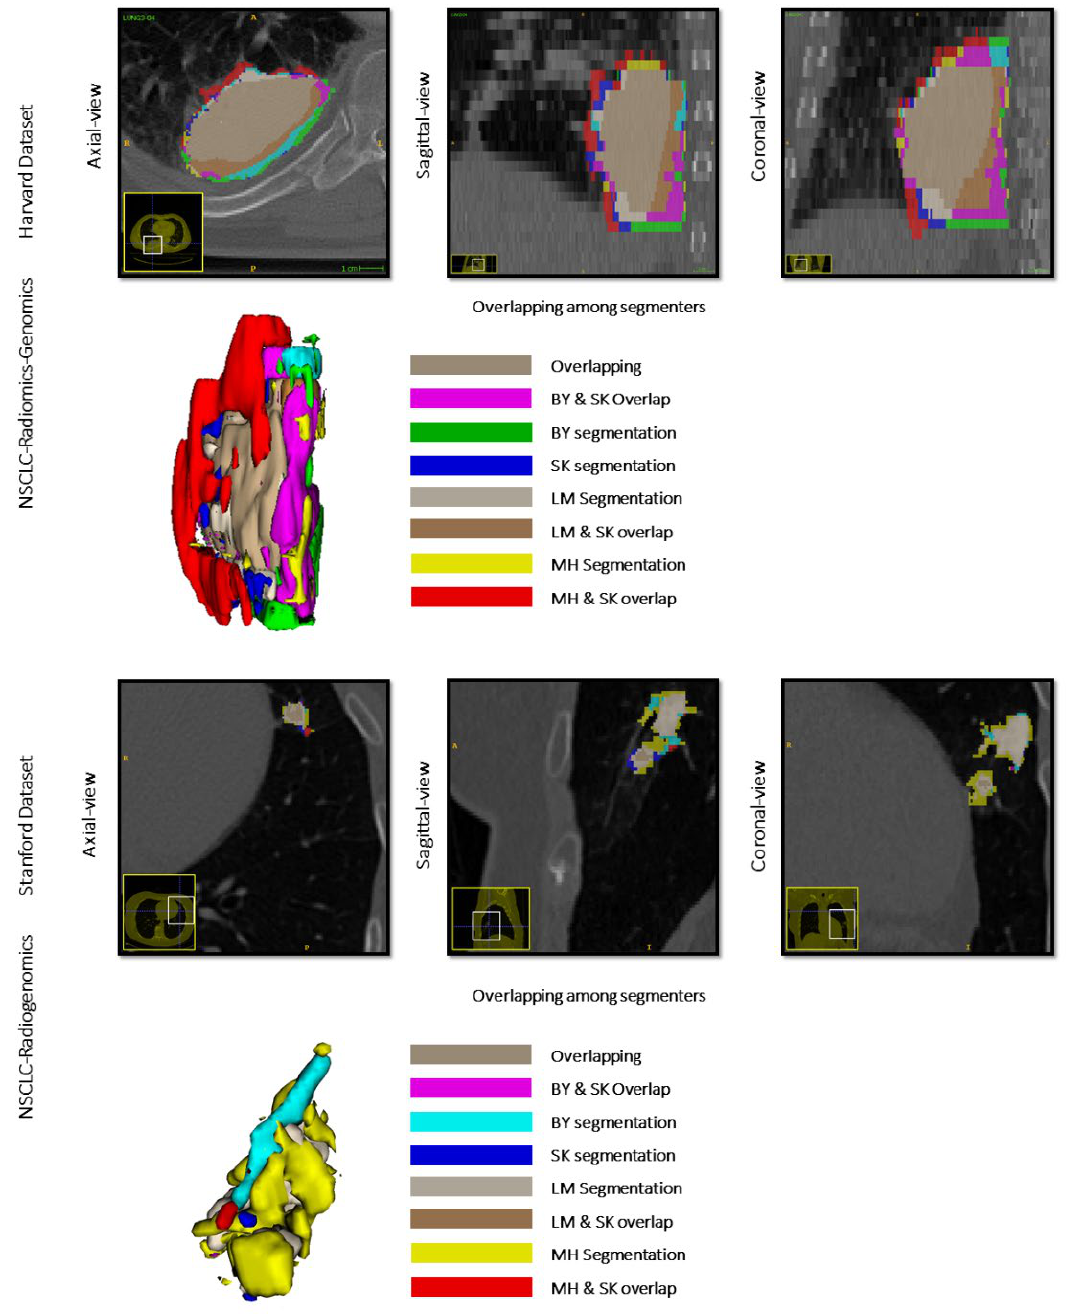
Figure 4. 3D tumor volume. 3D tumor volumes for four segmentation cases and two different NSCLC Radiogenomics datasets.